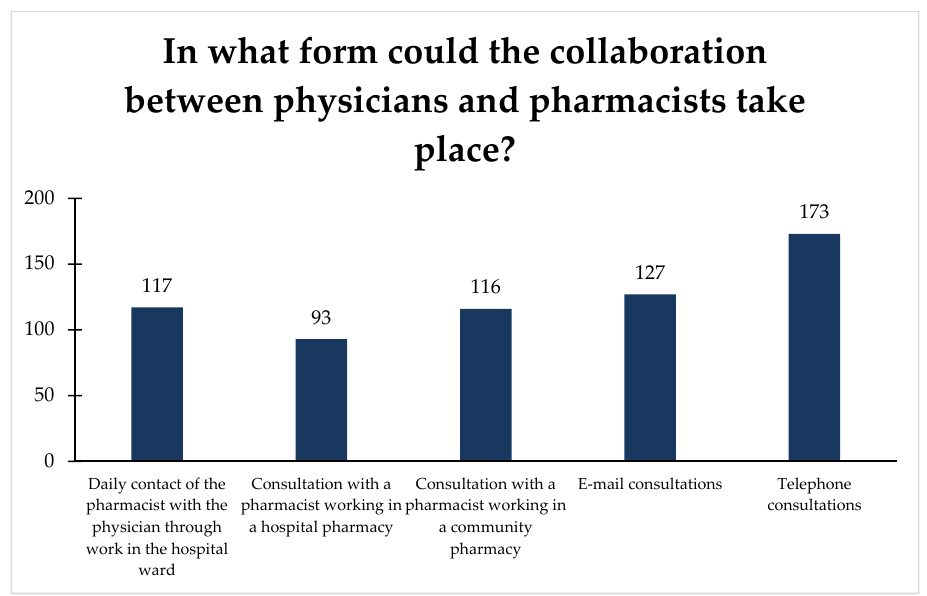
Figure 3. Proposed forms of collaboration. Answer the question: In what form could the collaboration between physicians and pharmacists take place?